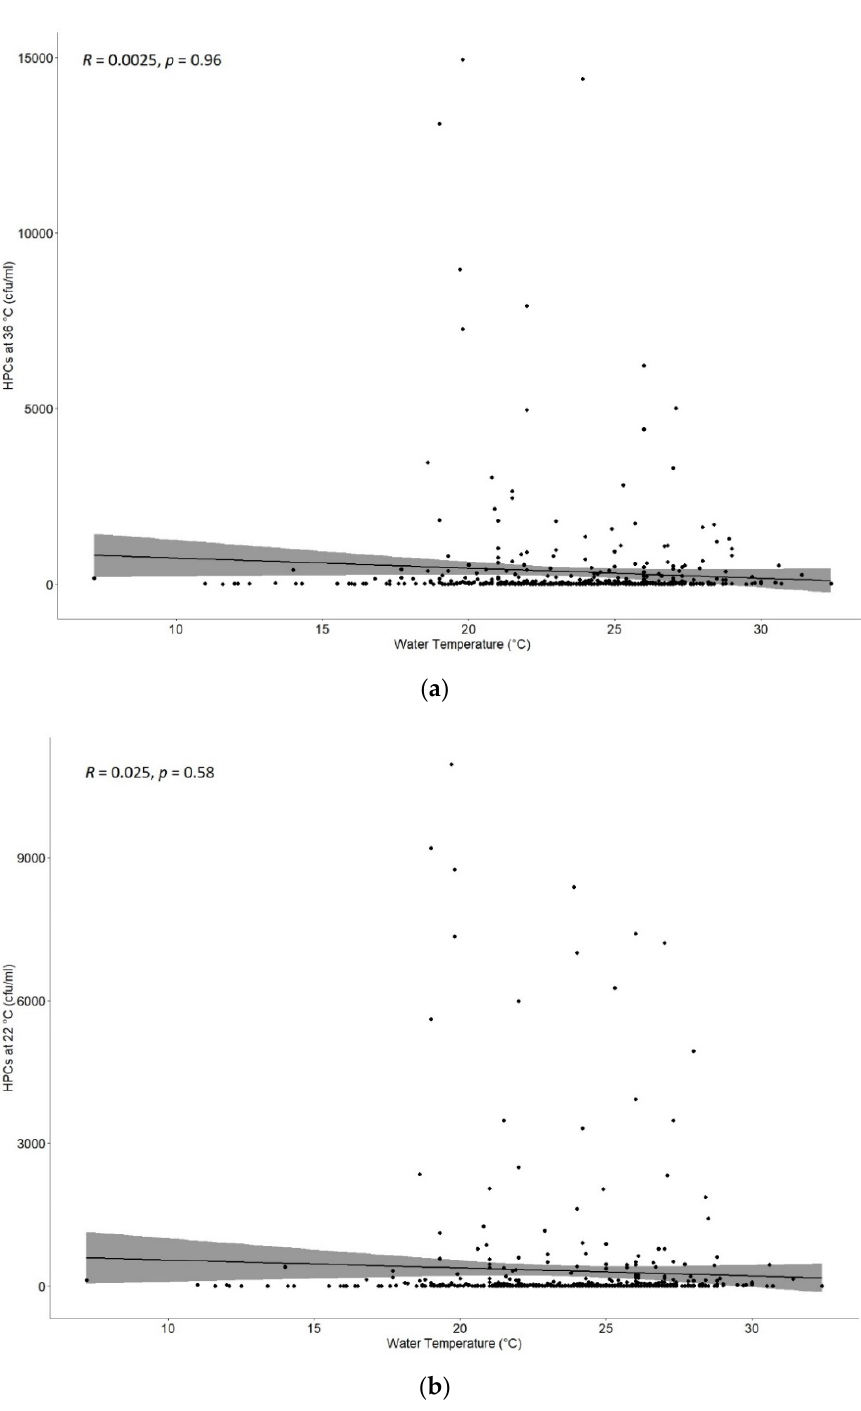
Figure 3. ( a ) Correlation between heterotrophic plate counts (HPCs) at 36 ◦ C and the temperatures detected during the drinking water monitoring program. There was no significant correlation with a p -value = 0.96. ( b ) Correlation between heterotrophic plate counts (HPCs) at 22 ◦ C and the temperatures detected during the drinking water monitoring program. There was no significant correlation with a p -value =